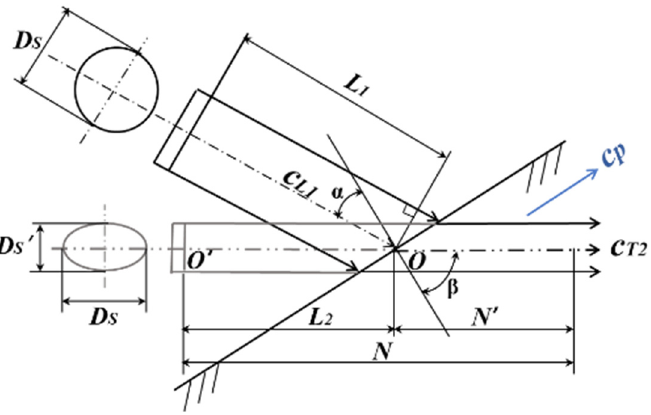
Figure 1. Lamb wave sound